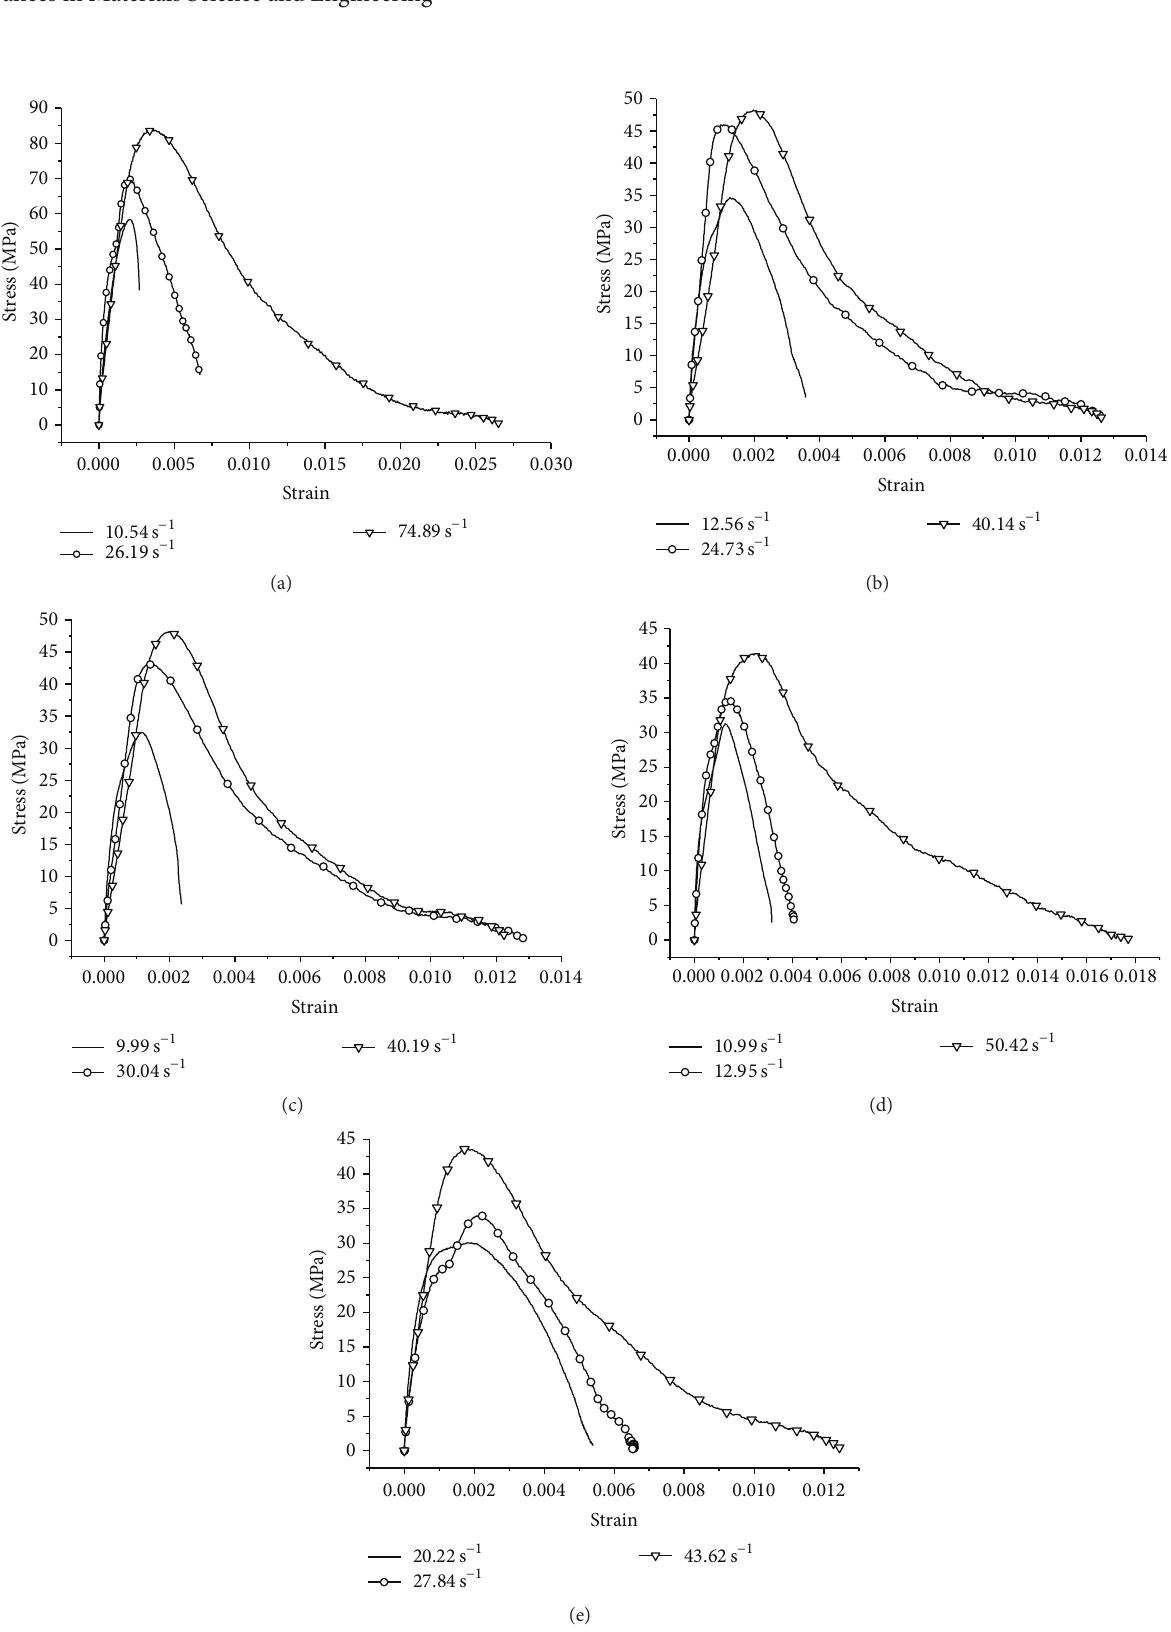
Figure 6: Stress versus strain curves of RAC